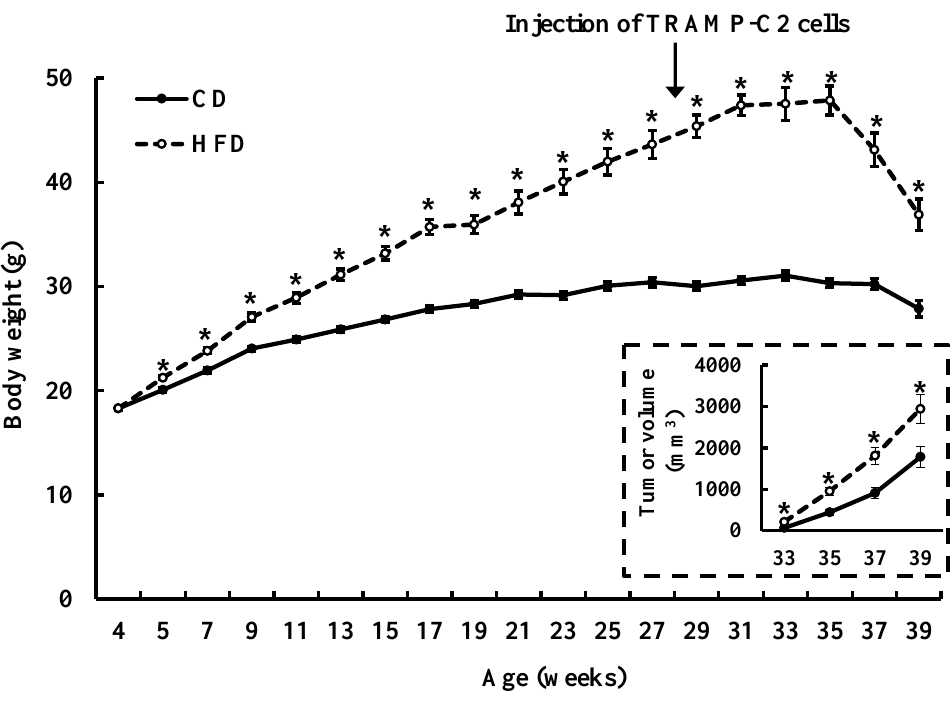
Figure 1. HFD feeding increases body weight in C57BL/6J mice injected with TRAMP-C2 cells. Four-week-old, male C57BL/6J mice were fed a control diet (CD, 10 kcal % fat) or high-fat diet (HFD, 60 kcal % fat) for a period of 24 weeks. At 28 weeks of age, TRAMP-C2 cells were subcutaneously injected into the right rear flanks of the mice. Eleven weeks after the TRAMP-C2 cell injection, all mice were sacrificed. Body weights of mice were measured every week. Results represent the means ± SEM ( n = 10). The dotted box in the figure shows changes in tumor volume. * p < 0.05 as compared with the CD group. Table 2. The body weights and organ weights of mice injected with TRAMP-C2 cells. Body Liver Tumor Epididymal Mesenteric Fat